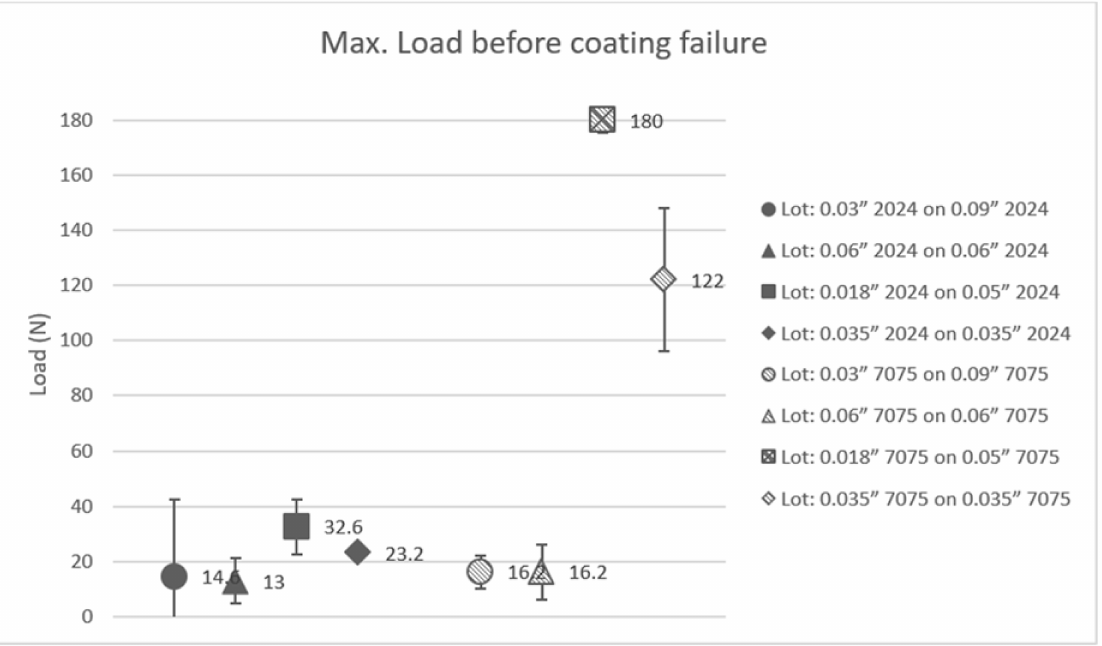
Figure 17. Averaged maximum bend angle from the horizontal plane before coating